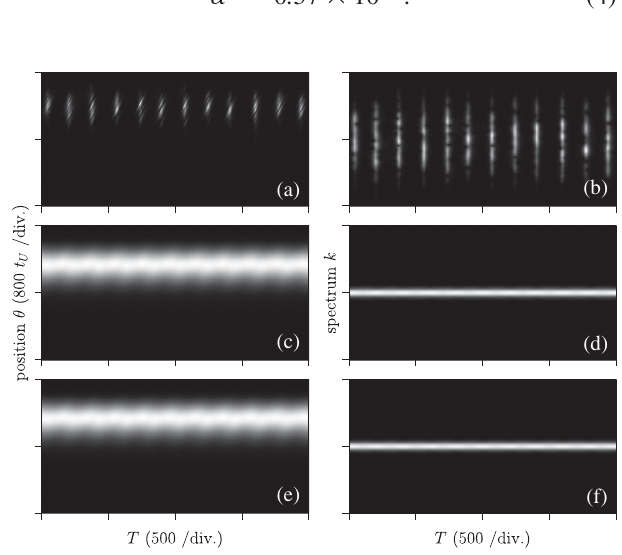
FIG. 5. Numerical solution of the FEL model (5). Left figures are the pulse shapes versus time j e ð (cid:5); T Þj 2 , and right figures are the optical spectra [ j ~ e ð k; T Þj 2 , where ~ e ð k; T Þ is the Fourier trans- form of e ð (cid:5); T Þ ]. The four upper figures correspond to realistic conditions: without feedback [(a) and (b)], and without feedback [(c) and (d)]. The two lower figures are reference cases (with feedback), considering an artificial condition where the sponta- neous emission noise (cid:4) is taken equal to zero. Parameters are v ¼ 6 , (cid:3) ¼ 1 (cid:4) 10 (cid:1) 4 , and a ¼ 600 . (cid:4) ¼ 1 (cid:4) 10 (cid:1) 14 for (a)–(d), and (cid:4) ¼ 0 for (e) and